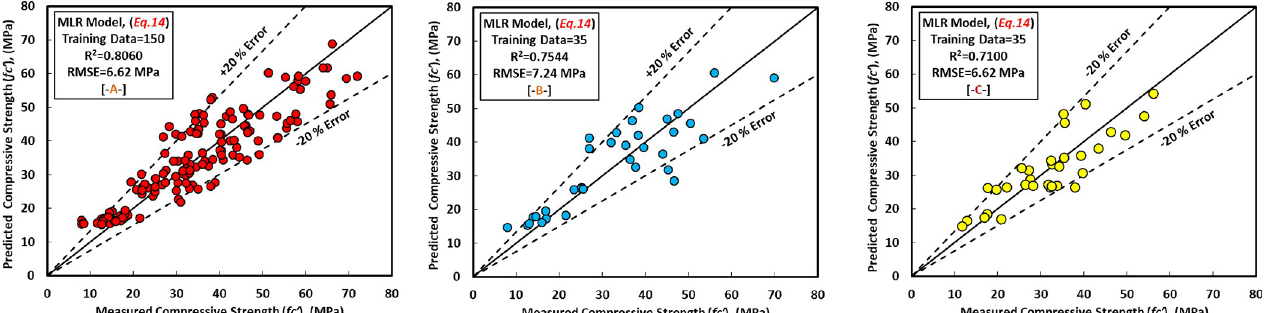
PLOS ONE | https://doi.org/10.1371/journal.pone.0265846 May 25,